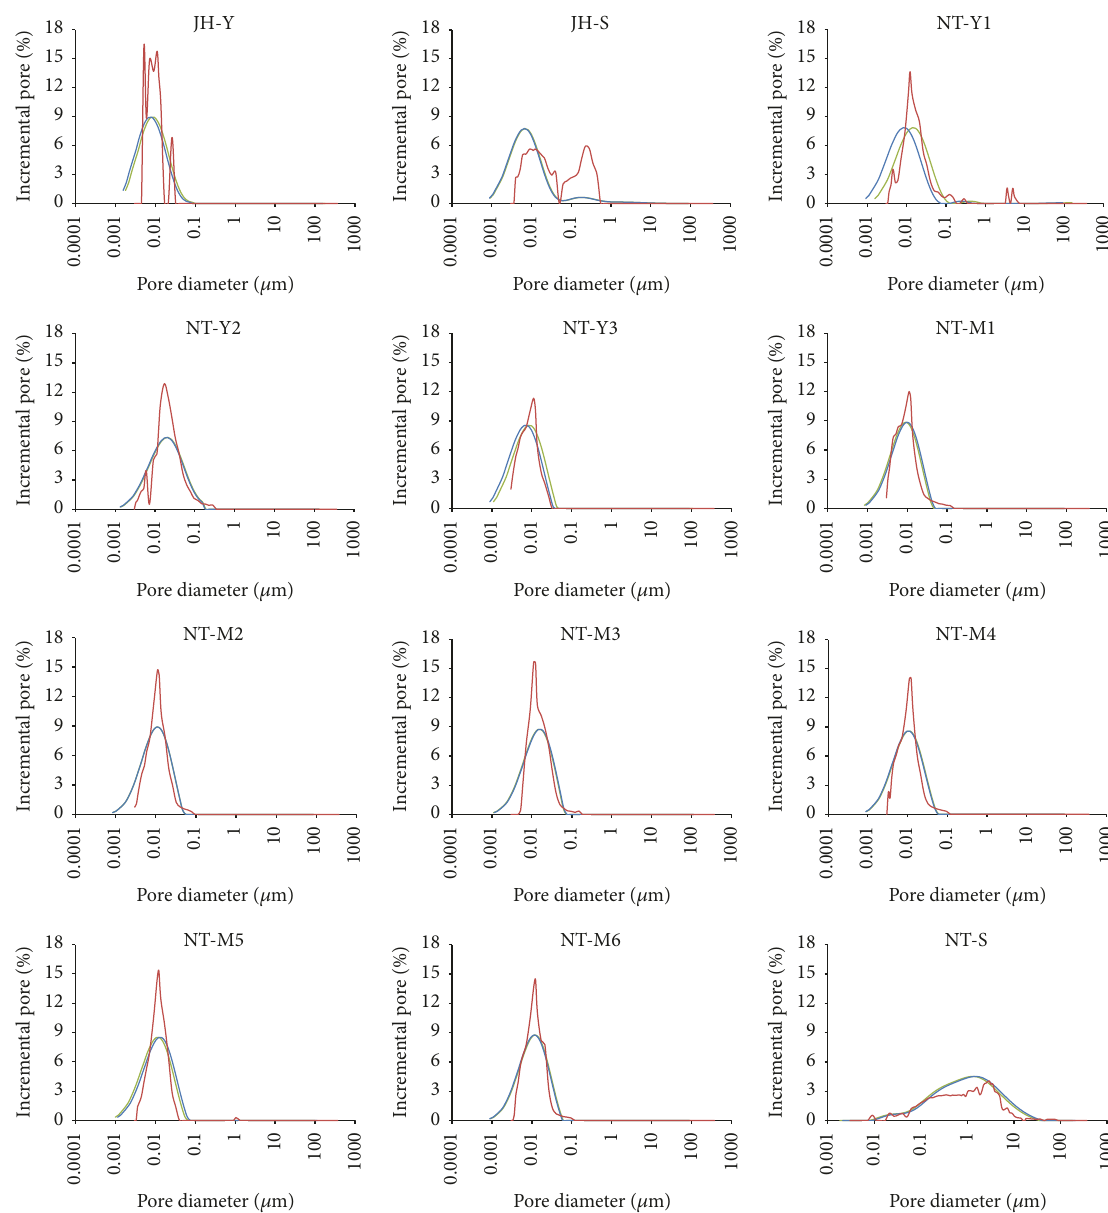
Figure 12: NMR PSD curves calibrated by the 𝑇 2 𝑃 𝑐 (green line) and WAM (blue line) methods compared with MIP PSD curves (red line). agreement between them is very good. It is thus inferred that the KT model is more suitable for the permeability prediction of sandstones rather than